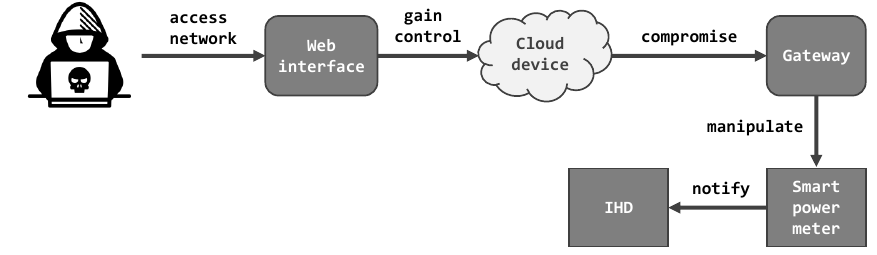
Figure 5. Attack scenario for hijacking of smart meters in smart